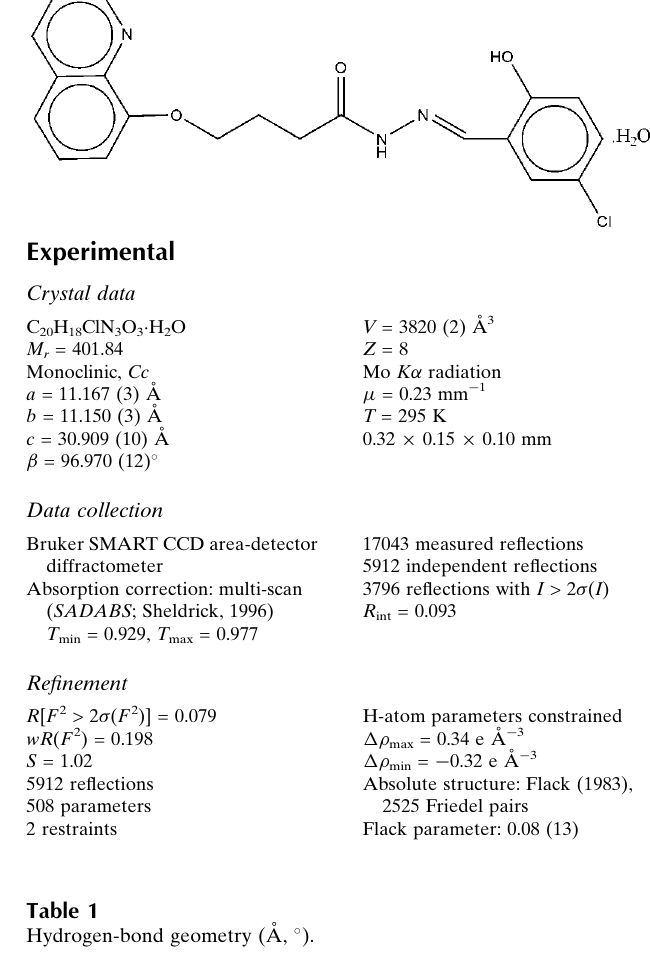
Hydrogen-bond geometry (A˚ , (cid:3)